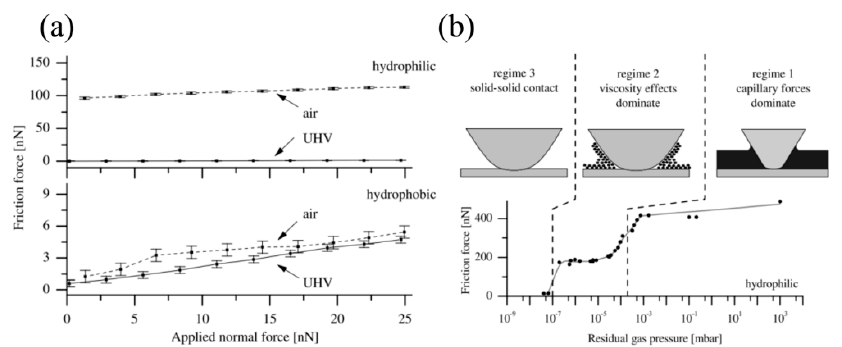
Figure 18. ( a ) A comparison of friction coe ffi cients between hydrophobic and hydrophilic surfaces in air and ultra-high vacuum (UHV). The friction force of hydrophilic silicon is greater in air than in UHV while the friction force of hydrophobic silicon is almost the same under these two conditions. ( b ) The friction force of hydrophilic silicon versus residual pressure and a schematic model of water coverage in various coverage regimes determined by the friction behaviors. Reprinted from Ref. [121], Copyright 2002, with permission from